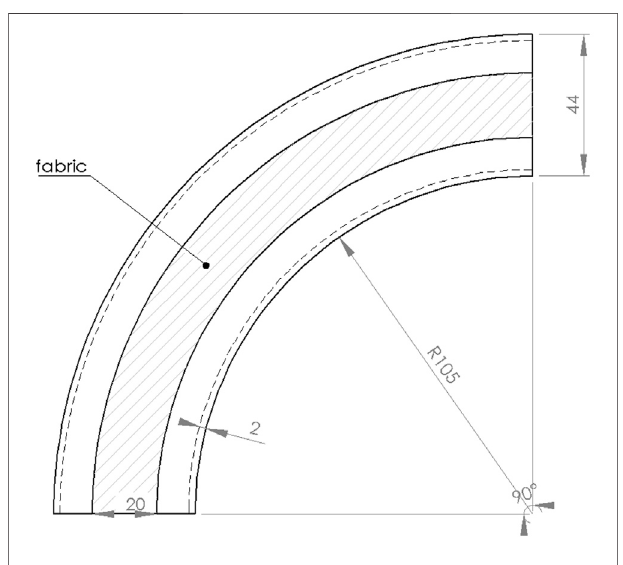
FIGURE 6 | Soft robot dimension.